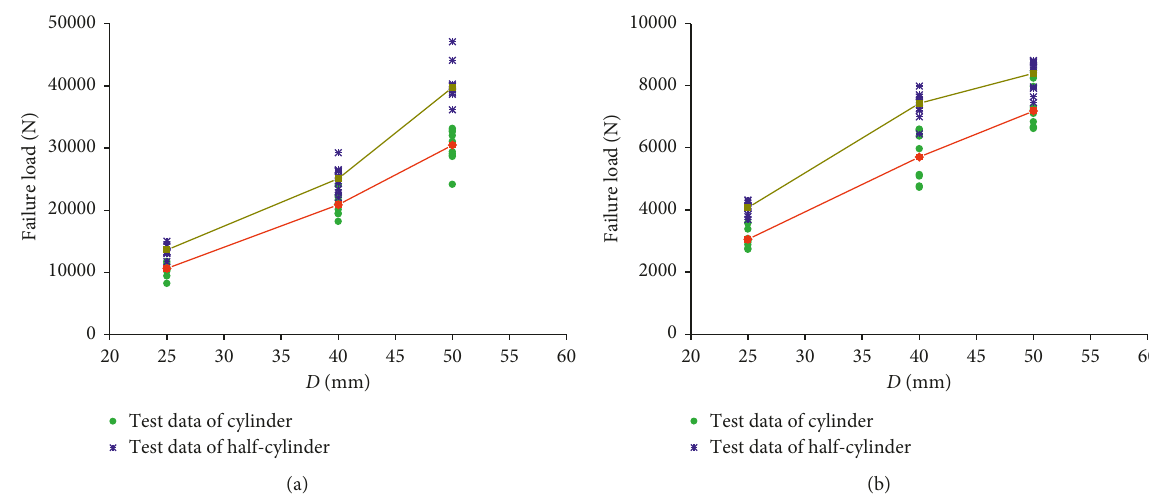
Figure 14: The results of the failure load with the distance D from the laboratory tests: (a) granitic and (b) sandstone.